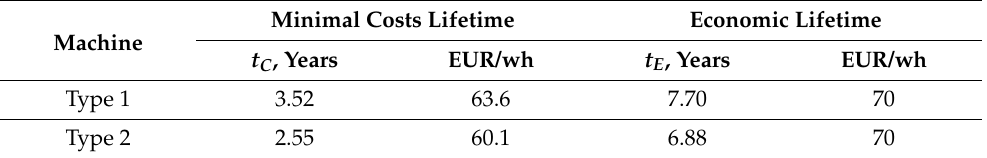
Table 3. Calculated results of costs analysis.